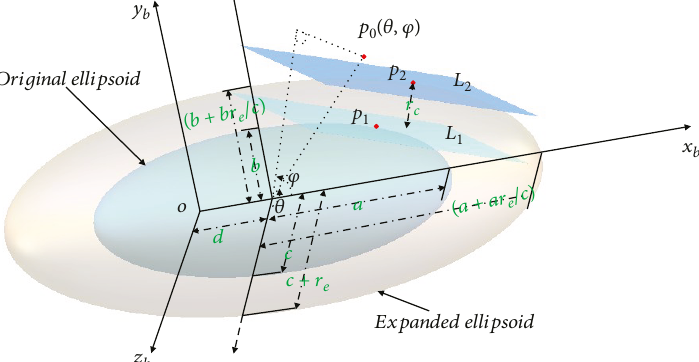
Figure 5: Scheme for discriminating collision avoidance between the original ellipsoid and the